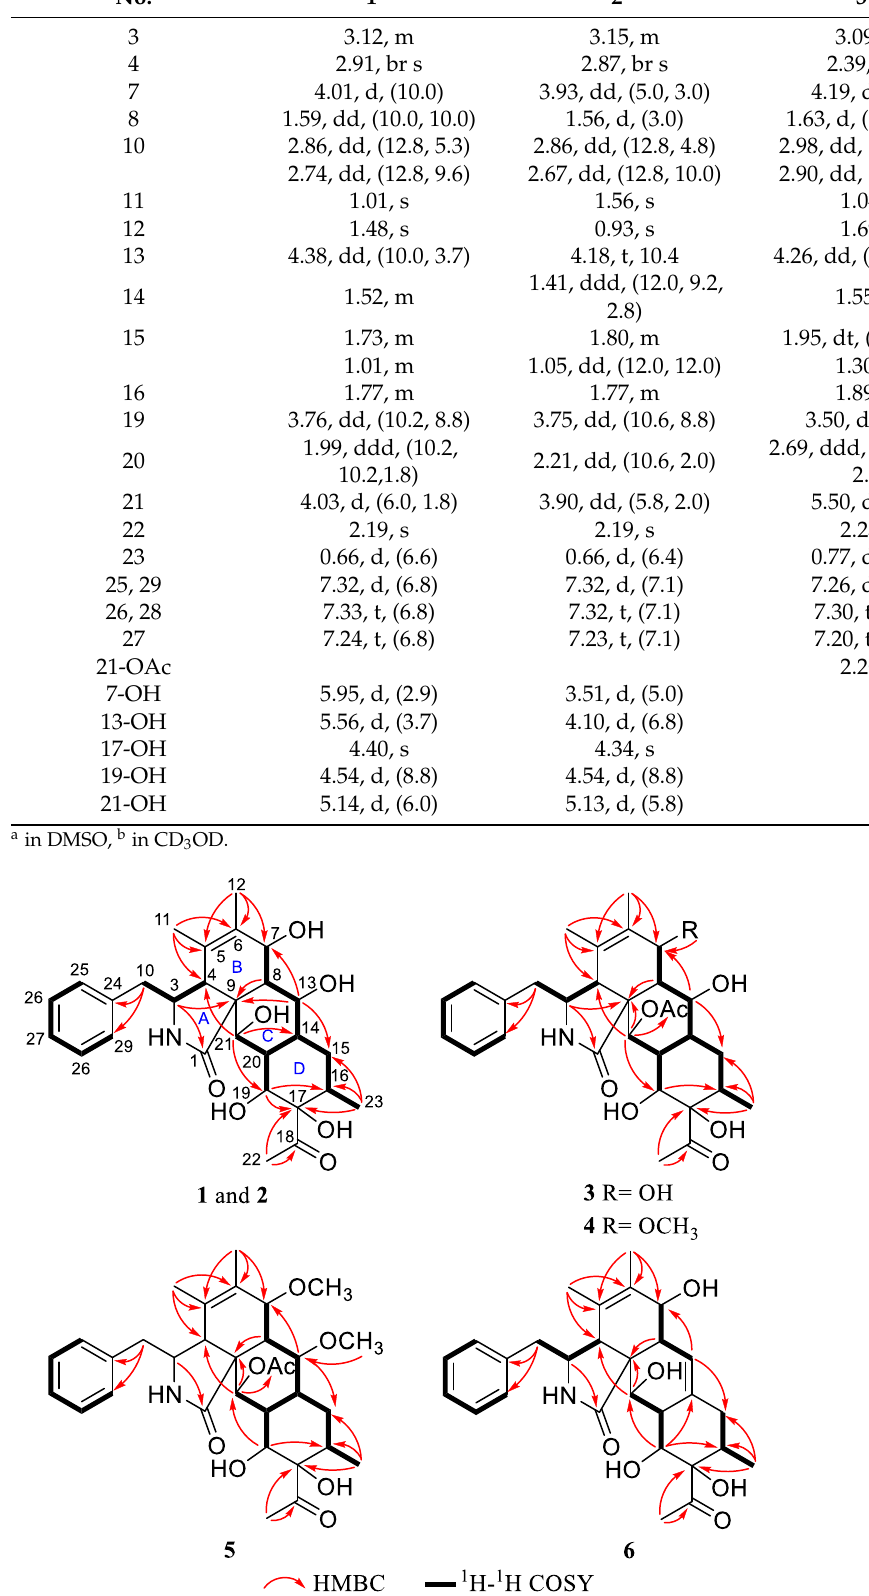
Figure 2. Key HMBC and 1 H- 1 H COSY correlations of compounds 1 – 6 . Compound 2 was obtained as a colorless powder and had the same molecular for- mula (C 28 H 37 NO 7 ) as compound 1 , according to HRESIMS. Their NMR (Tables 1 and 2) signals were almost identical, except that the coupling constant of H-7/H-8 (3.0 Hz) in 2 was smaller than the coupling constant of H-7/H-8 (10.0 Hz) in 1, which indicated 2 as an epimer of 1 . In addition, from 2D NMR correlations (Figure 4), the NOE correlations of 7- OH/H-13, and H-7/H-8, coupled with the coupling constant of H-7/H-8 (3.0 Hz) confirmed that H-7 should be β -orientated. Finally, to assign the absolute configuration, ECD calcu- lation of 2 was performed at the B3LYP-D3(BJ)/6-311G* (IEFPCM, MeOH) level of theory, and the absolute configuration was deduced as 3 S , 4 R , 7 R , 8 S , 9 R , 13 S , 14 R , 16 S , 17 S , 19 R , 20 R , and 21 R - 2 by comparison of the experimental and calculated ECD data (Figure 3). Therefore, compound 2 can be fully assigned to Curtachalasin X2. Compound 3 was obtained as a colorless powder with the molecular formula deter- mined to be C 30 H 39 NO 8 by HRESIMS at m / z 564.2585 [M + Na] + (calcd for C 30 H 39 NO 8 Na + , 564.2568). A comparison of the NMR data (Tables 1 and 2) of 3 with 2 indicated that both compounds share the same skeleton, with the only difference between the two com- pounds being the presence of an acetyl moiety in 3 instead of a hydroxy in 2 . In the HMBC experiment, the correlation between H-21 ( δ H 5.50) and acetyl group ( δ C 172.5) was ob- served, which suggested that the acetyl group connects to the oxygen at position 21, as shown in Figure 1. The absolute configuration of 3 was assigned as 3 S , 4 R , 7 R , 8 S , 9 R , 13 S , 14 R , 16 S , 17 S , 19 R , 20 S , and 21 R by comparison of the calculated and experimental ECD data (Figure 3), Finally the structure of 3 was established and named as Curtachalasin X3. Compound 4 was isolated as a colorless amorphous powder and given a molecular formula of C 31 H 41 NO 8 by HRESIMS at m/z 578.2724 [M + Na] + (calcd for C 30 H 39 NO 8 Na + , 578.2724). Analysis of the 1D NMR data (Tables 1 and 3) showed characteristic signals, including a single substituted phenyl at δ H 7.32 (2H, t, J = 7.2 Hz, H-26/H-28), 7.25 (2H, d, J = 7.2 Hz, H-25/H-29), and 7.20 (1H, t, J = 7.2 Hz, H-27); five methyl groups ( δ C 26.1, 21.2,